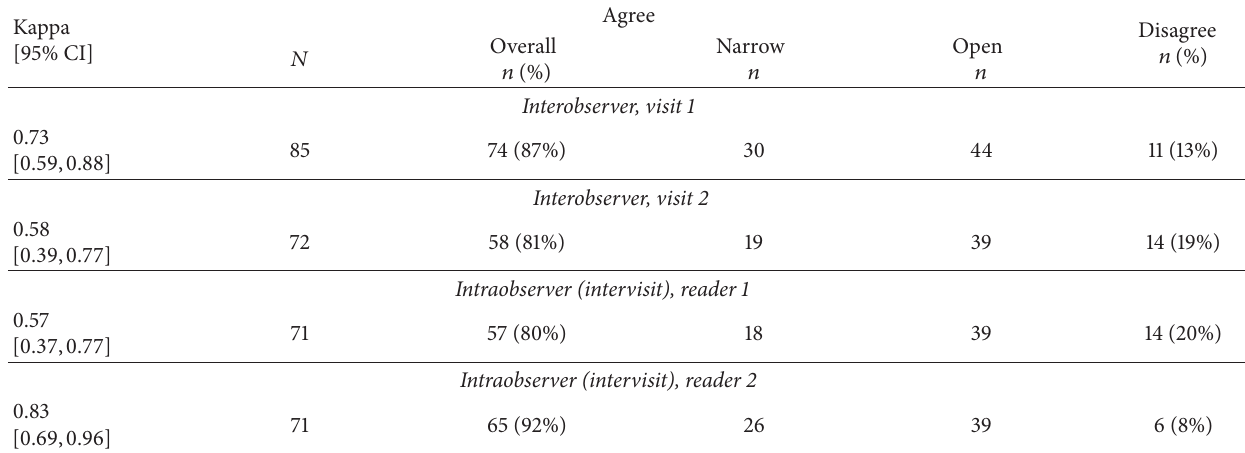
Table 4: Fourier domain anterior segment optical coherence tomography agreement for angle classification (kappa [95% confidence